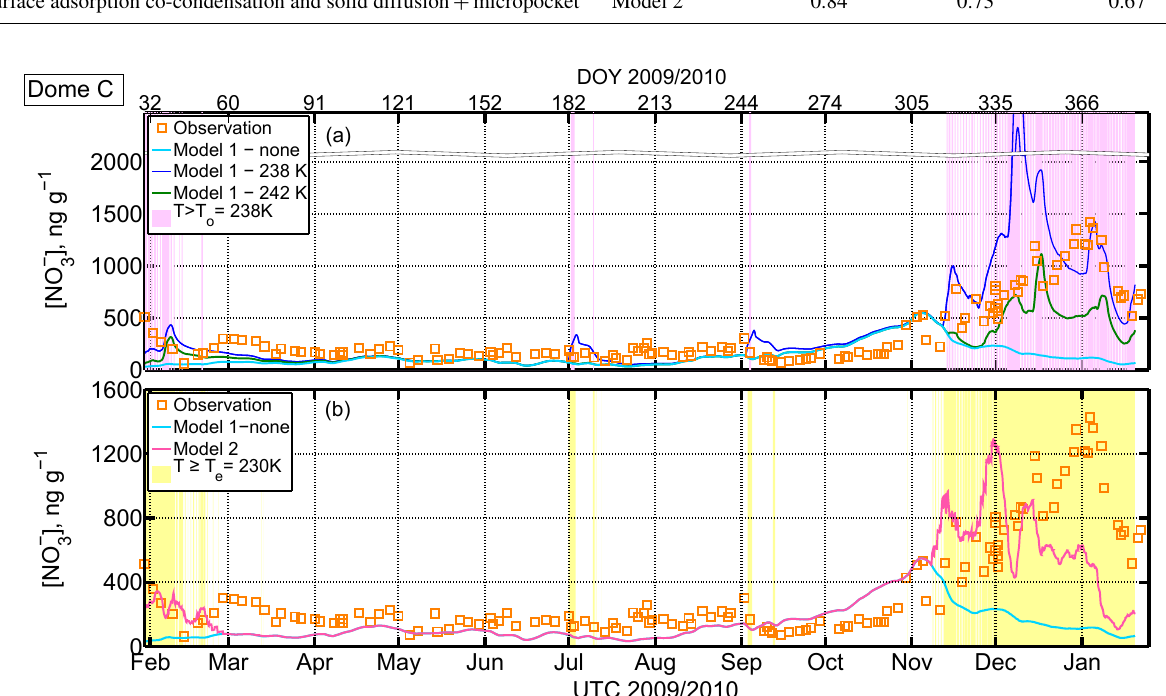
Figure 5. (a) Model 1 output of Dome C skin layer snow concentration of NO − . At T <T o the interface between air and snow grain 3 is assumed to be ice (air–ice) and the NO − concentration is determined by a combination of non-equilibrium adsorption on ice and co- 3 condensation coupled with solid-state diffusion. At T >T o , the interface between air and snow grain is assumed to be a DI (air–DI); i.e. the NO − concentration is determined by a combination of non-equilibrium solvation into the DI coupled with solid-state diffusion. Note that 3 the y axis is broken between 2000 and 3500ngg − 1 . Orange squares: observation; light blue: Model 1 with T o >T m , i.e. only air–ice inter- action; dark blue: Model 1 with T o = 238K; green: Model 1 with T o = 242K; the purple shaded area indicates times when T >T o = 238K; (b) Model 2 output of Dome C skin layer snow NO − concentration. The major interface between air and snow is assumed to be ice (air–ice) at 3 T <T m and the NO − concentration in ice is determined by a combination of non-equilibrium adsorption and co-condensation coupled with 3 solid-state diffusion. Above T >T e = 230K, liquid coexists with ice in the form of a micropocket. The partition between air and micropocket is determined by Henry’s law. Orange squares: observation; light blue: Model 1 with T o >T m , i.e. air–ice-only interaction; pink: Model 2 – air–ice interaction plus micro-liquid pockets; yellow shaded area indicates times when T >T e = 230K ( T e for HNO 3 –H 2 O